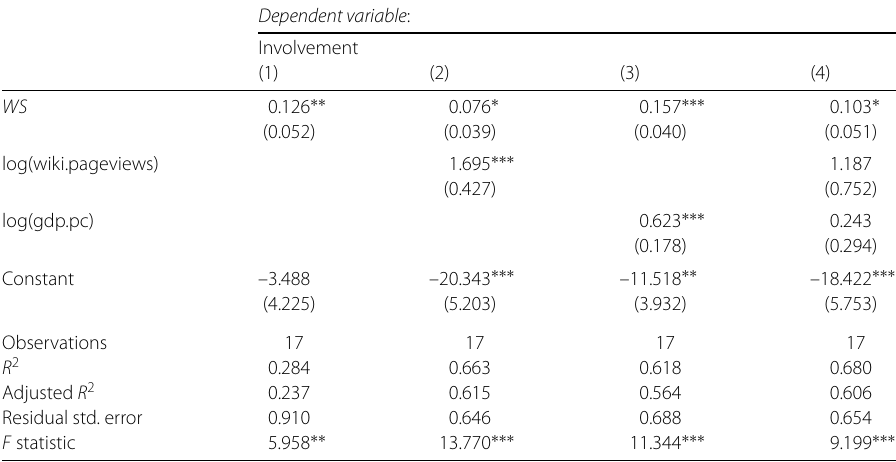
Table 6 The direct relationship between World Bank’s broad support and WS , controlling for a country’s popularity and its GDP PPP per capita Dependentvariable : Involvement (1) (2) (3) (4) WS 0.126